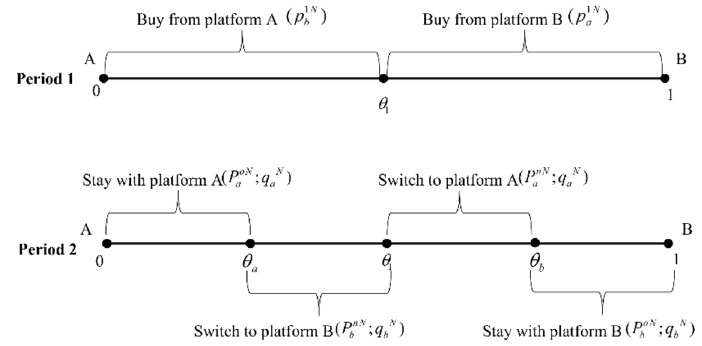
Figure 2. The benchmark model.